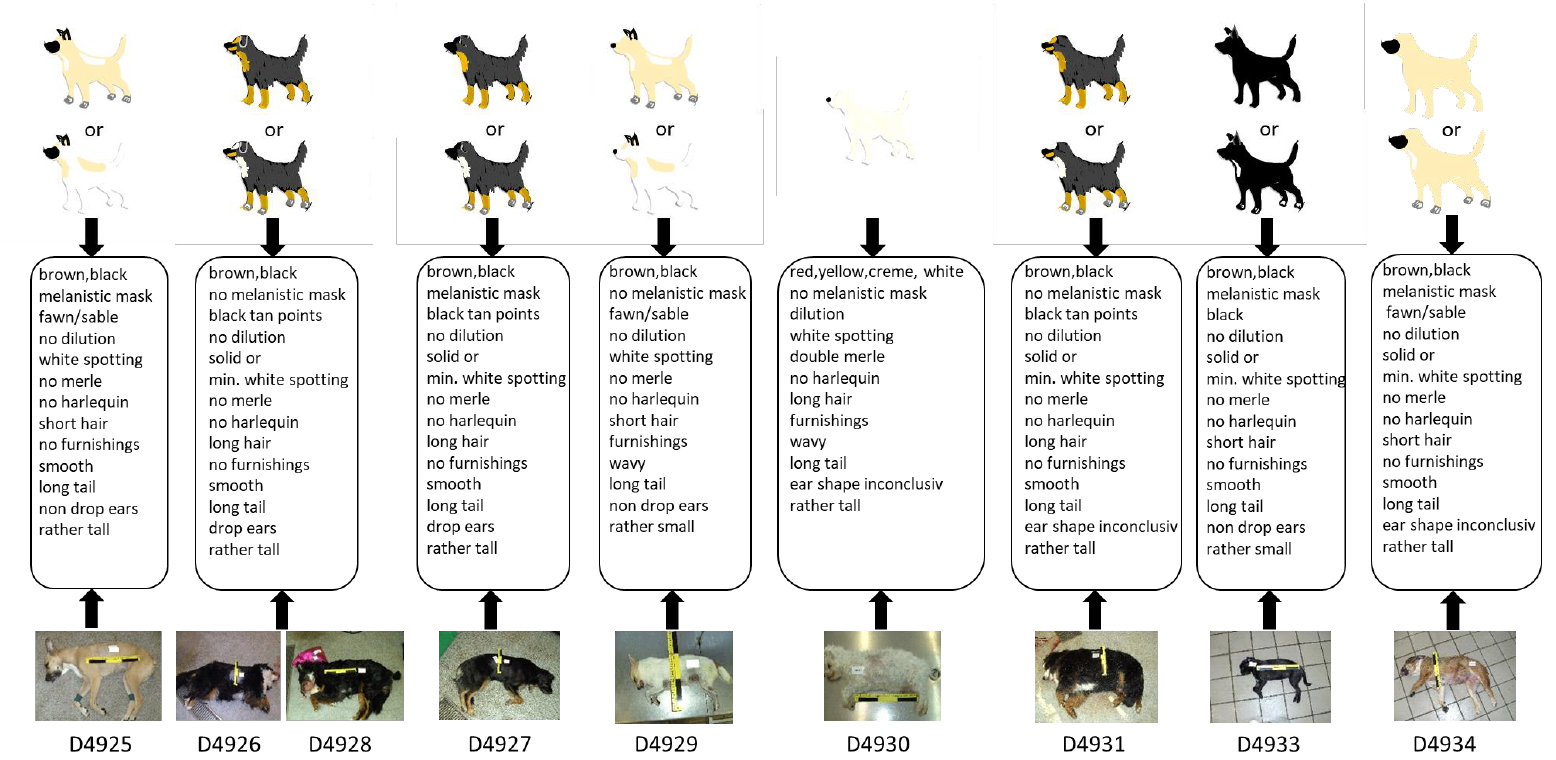
Figure 2. Results of the blind test: Identikit pictures (sketches) were drawn based on the genotypes and subsequently compared with photos of the nine tested dogs. Uncertainties in the manifestation of some visible characteristics required up to two versions of the identikit pictures. For all but one dog (D4930), two versions were necessary in order to reflect the possible phenotypes obtained from the genotype data. Dogs D4926 and D4928 showed the same genotype and therefore identical sketches. In general, identikit pictures and photos showed high levels of similarity. min. = minimal.